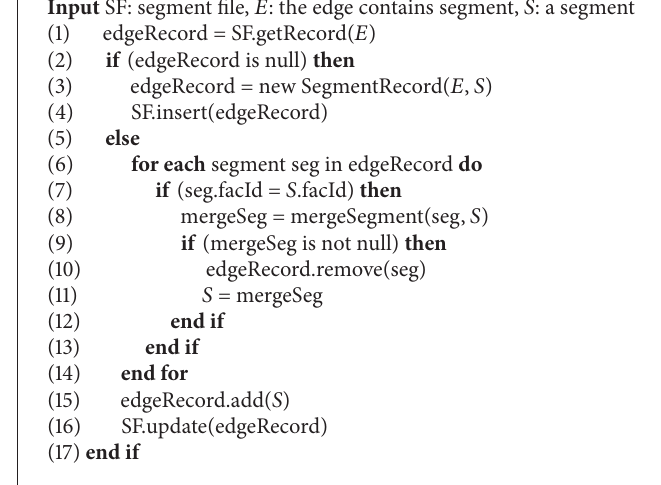
Algorithm 3: insertSegment(SF, 𝐸 , 𝑆 ).